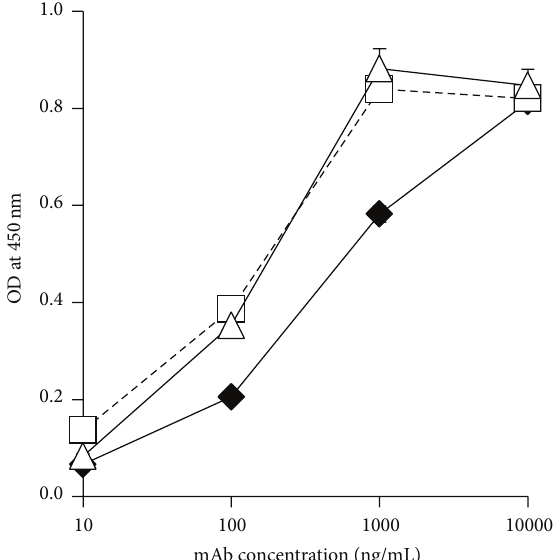
Figure 4: Binding activity of DOTA-conjugated 11-25 mAb and 64 Cu-DOTA-11-25 mAb to recombinant MSLN determined by ELISA as compared with native 11-25 mAb. Native 11-25 mAb (open triangles) and DOTA-conjugated 11-25 mAb (open squares) and 64 Cu-DOTA-11-25 mAb (closed diamonds) were added to the wells on which MSLN had been immobilized. Antibody binding was detected with peroxidase- labeled anti-mouse IgG and TMB. The reaction was stopped with 2 N H 2 SO 4 and the absorbance at 450 nm was measured.